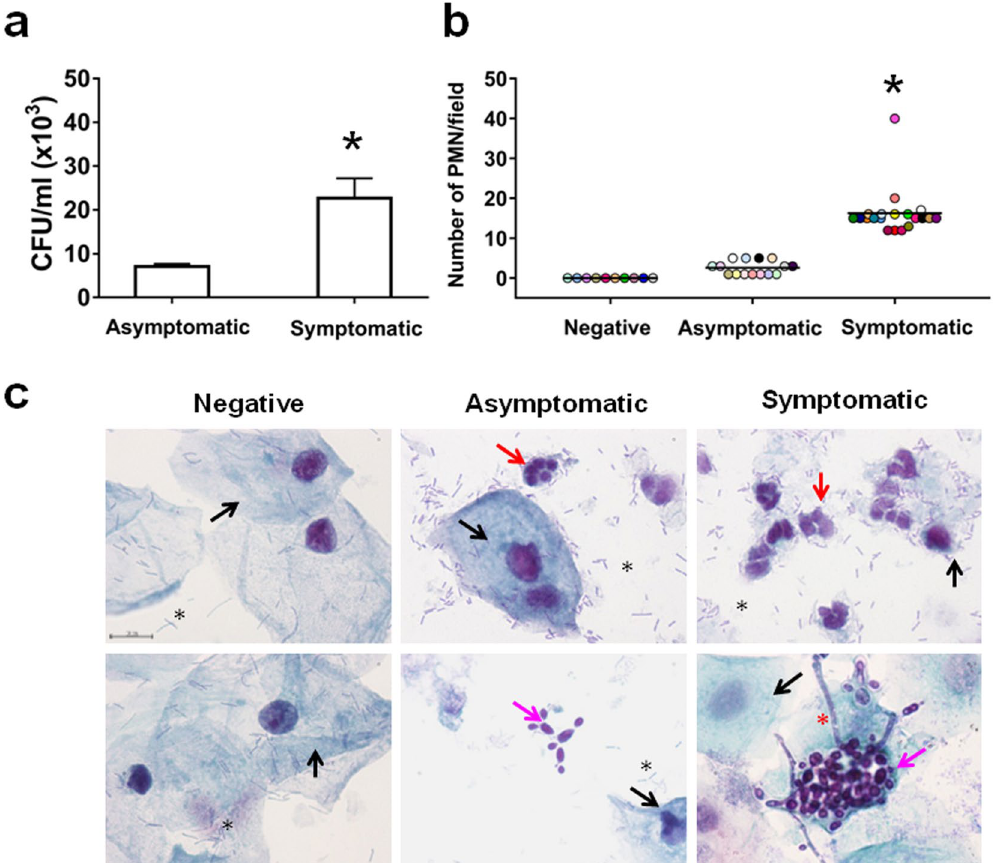
Figure 1. Determination of fungal burden and PMN infiltration in vaginal samples. The CFU in vaginal samples of asymptomatic (n = 5) and symptomatic (n = 5) women were evaluated and the statistical significance was determined with Student’s t test. Data are expressed as mean ± SEM. * p = 0.016 symptomatic vs asymptomatic women ( a ). Vaginal samples of negative (n = 10, identified by dots with different colors), asymptomatic (n = 15, identified by dots with different colors) and symptomatic (n = 20, identified by dots with different colors) women were examined under light microscope to evaluate the PMN recruitment by morphology. The statistical significance was determined with Mann Whitney U test. * p = 3.07 × 10 − 10 symptomatic vs asymptomatic women ( b ). Vaginal samples of negative (n = 10), asymptomatic (n = 15) and symptomatic (n = 20) women were microscopically examined to evaluate the presence of epithelial cells ( → ), PMN ( → ), lactobacilli ( * ) and C . albicans in yeast ( → ) or hyphal form ( * ) (original magnification x1000, bar = 10 μ m). Representative images of each kind of vaginal samples (upper and lower panels) shown are from three different women ( c